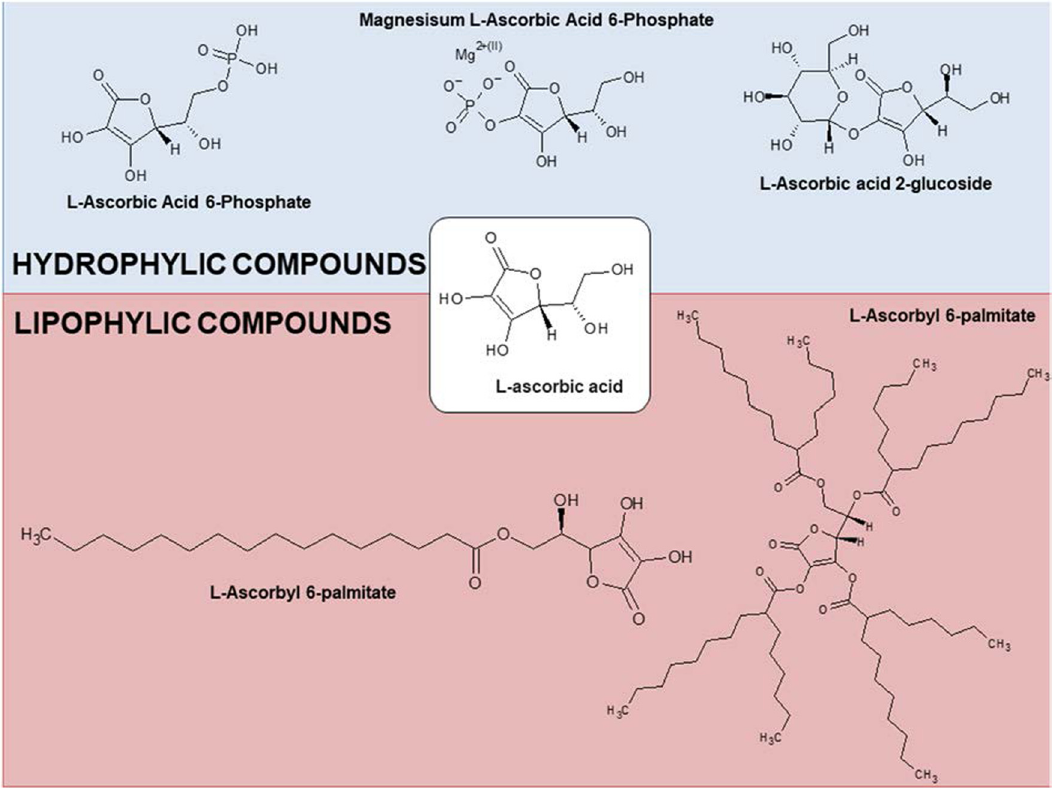
Figure 10: The structure of L - ascorbic acid and its derivatives [ 161,162 ]